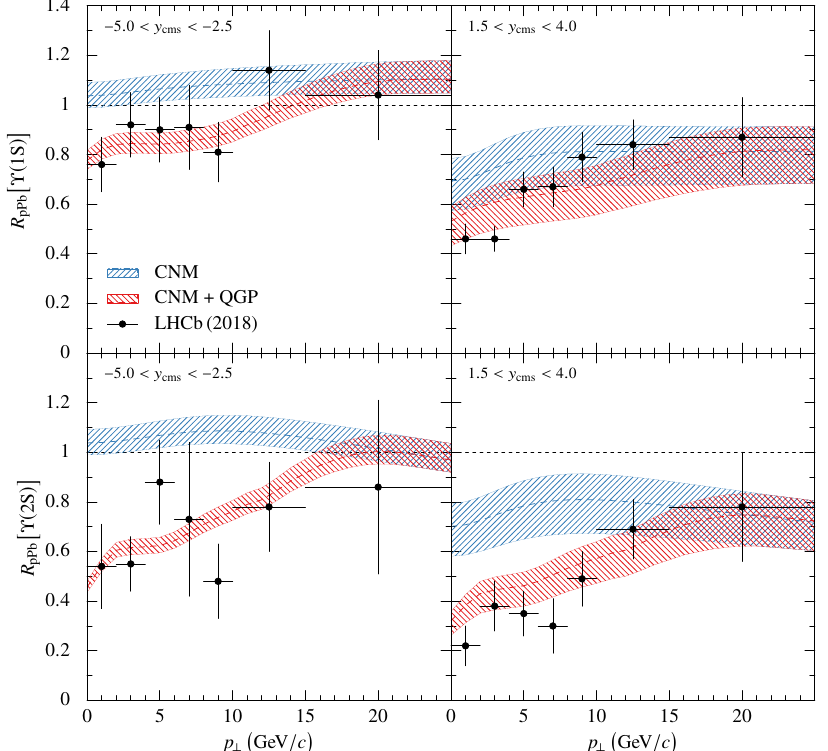
(cid:1) √ s NN = 8.16 TeV with LHCb